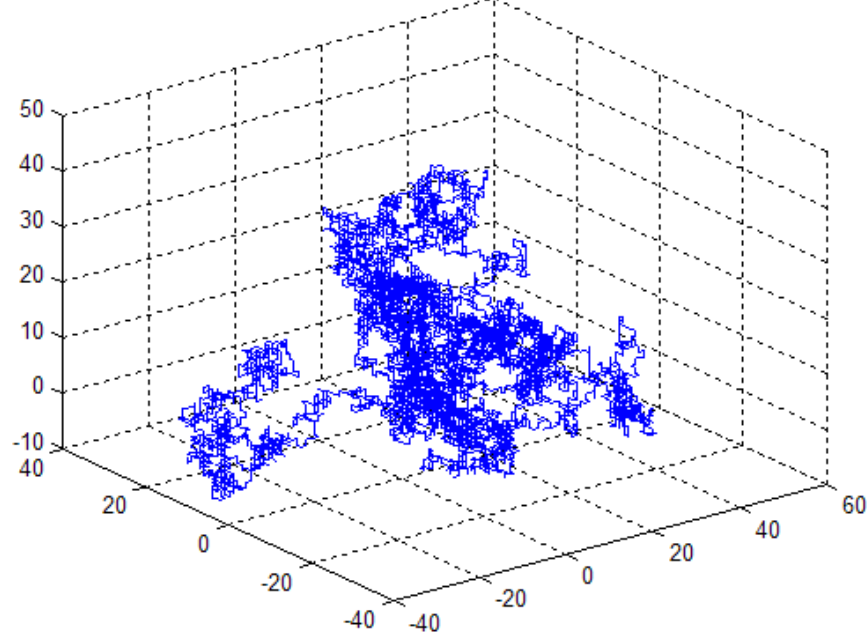
Figure 1. Example of a three-dimensional random walk simulated using the Matlab Econometrics Toolbox